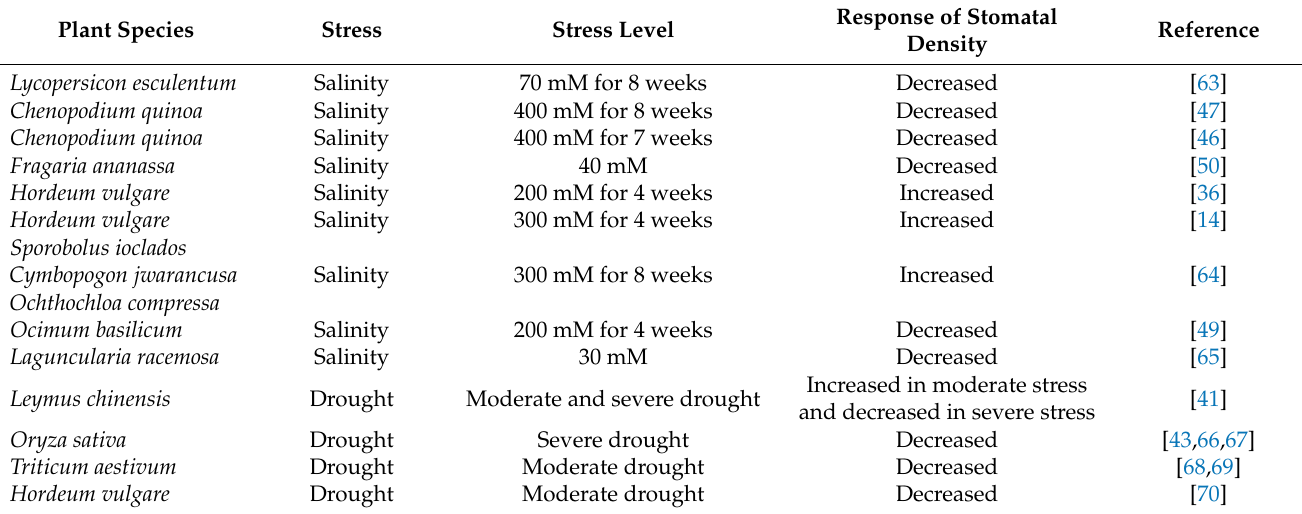
Table 1. Osmotic stress-induced changes in stomatal density in different plant